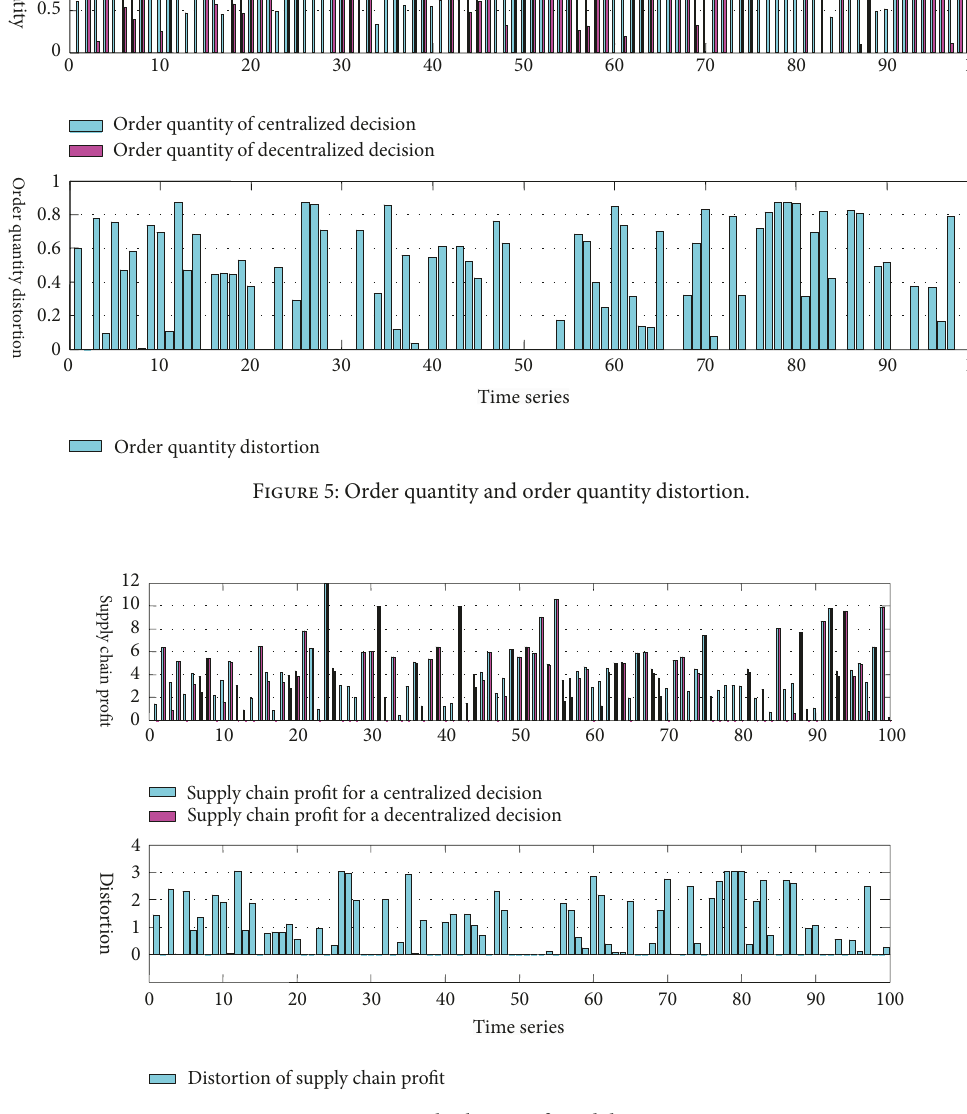
Figure 6: Supply chain profit and